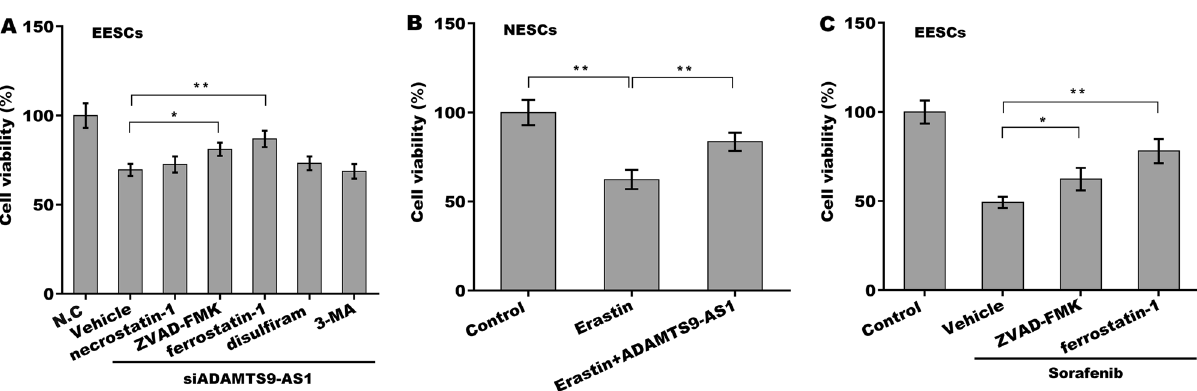
Figure 3. ADAMTS9-AS1 increased ESC viability by regulating ferroptosis. ( A ) Cell viability of EESCs was assessed after ADAMTS9-AS1 knockdown using a CCK-8 assay in the presence of the indicated inhibitors (ZVAD-FMK, 10 μM; necrostatin-1, 10 μM; ferrostatin-1, 1 μM; disulfiram, 5 μM; 3-MA, 10 mM). ( B ) Cell viability of NESCs was assessed after ADAMTS9-AS1 overexpression using a CCK-8 assay in the presence or absence of erastin (10 μM). ( C ) Cell viability of EESCs was assessed after treatment with the indicated inhibitors (ZVAD-FMK, 10 μM; ferrostatin-1, 1 μM) in the presence or absence of sorafenib (5 μM). p < 0.05, ** p <